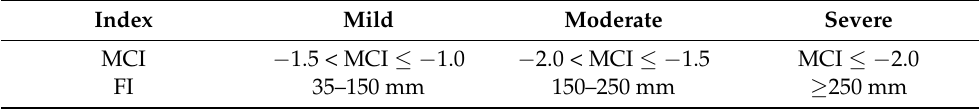
Table 2. Classification standard of drought and flood disaster in Cangnan